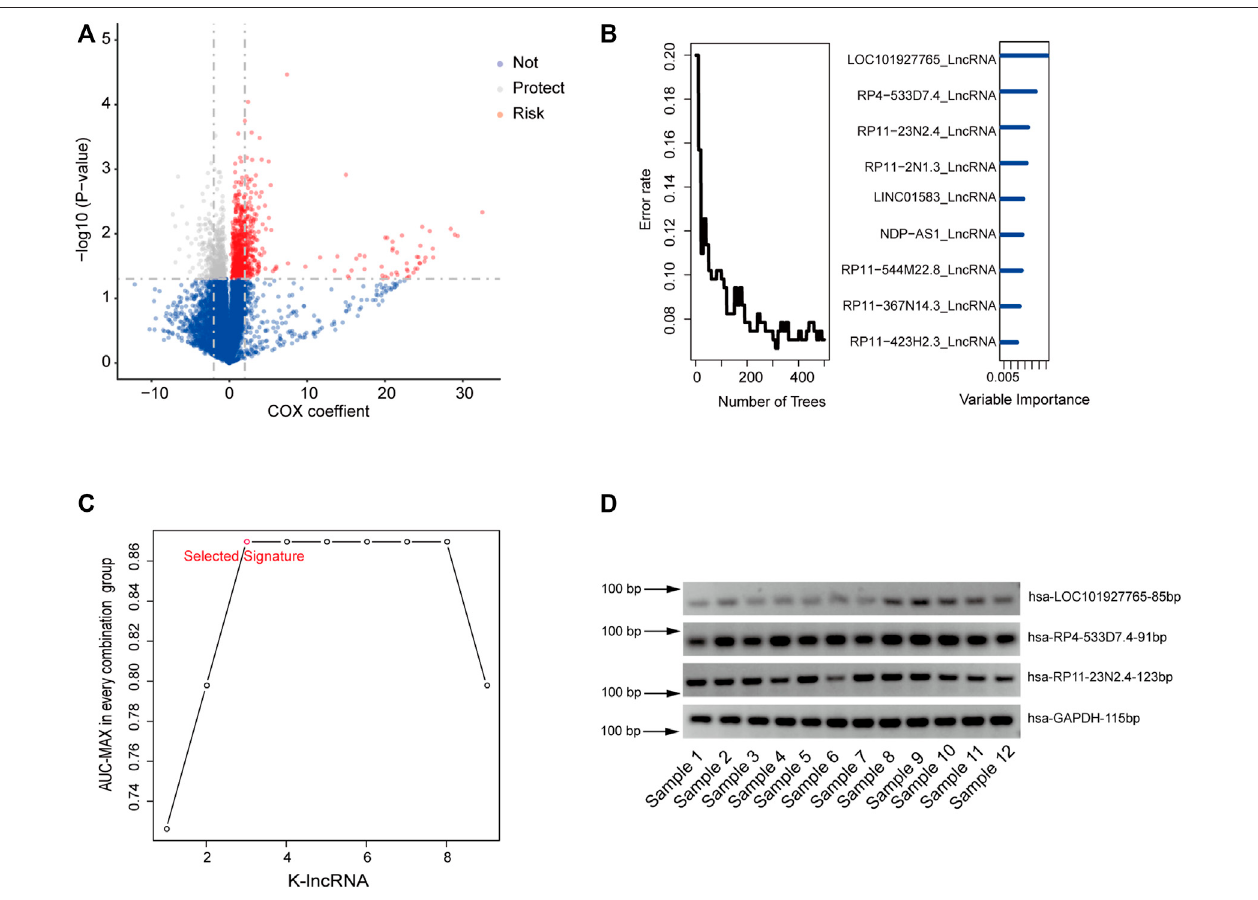
FIGURE2| IdentifyingtheLncRNAsignatureinthetrainingdataset. (A) ,UnivariateCoxproportionalhazardsregressionanalysisofthelncRNAexpressionpro fi ling datainthetrainingdataset. (B) ,IdentifyingthelncRNAsbyRFSCalgorithm. (C) .TheAUCofall511signatureswerecalculatedandtheninehighestAUCfork (cid:1) 1,2 ... 9is shown in the plot by ROC analysis for the lncRNA signatures predicting model in the training dataset. (D) , Agarose electrophoresis of selected lncRNAs PCR products.